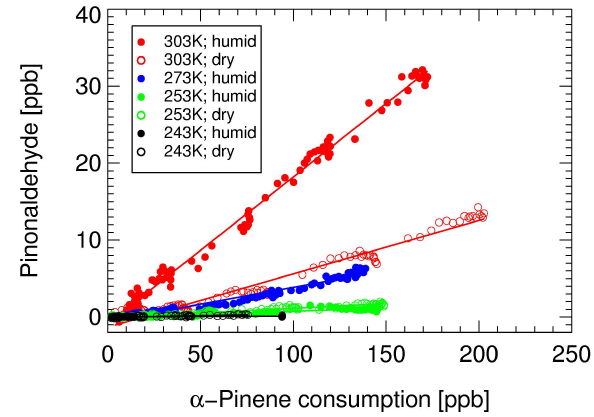
Fig. 4. Mass ratio of water to organics (w/org) as function of the mass load of SOA at 303K and 253K (colour) under dry (open symbols) and humid conditions (filled symbols) as derived by AMS.